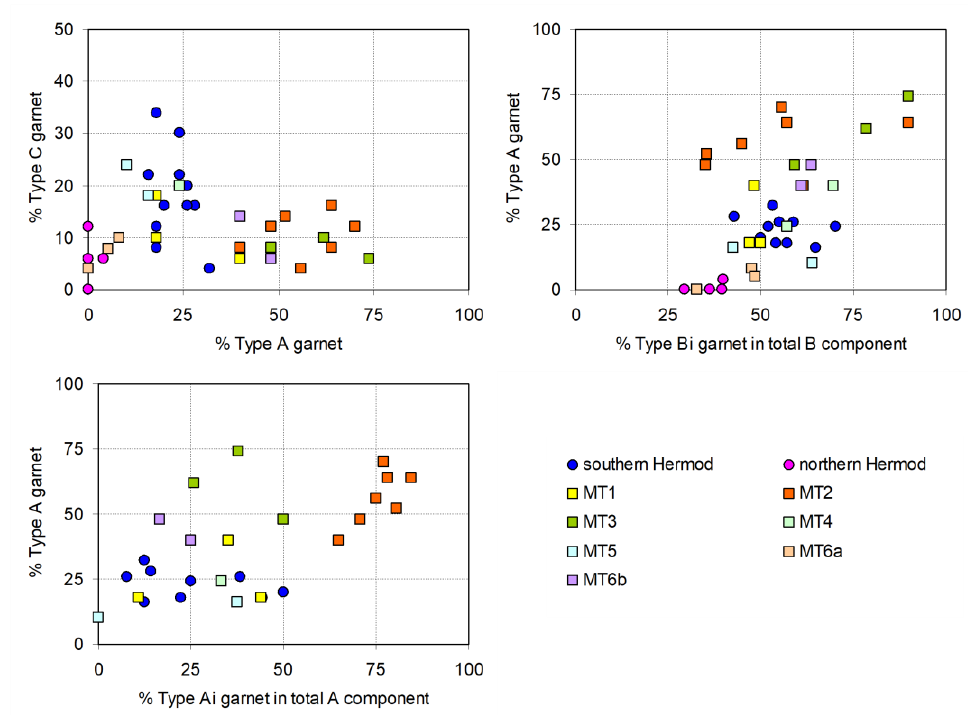
Figure 11. Comparison of garnet assemblage compositions in Hermod S2 sandstones with those found in Units MT1–MT6 (Morton et al., 1993). MT1 data from Norwegian wells 25/2-1 and 26/4-1; MT2 from UK wells 9/12-2 and 9/13-1; MT3 and MT4 from UK Well 9/13-1: MT5 from UK wells 9/13-1 and 9/23-1; MT6a from Norwegian wells 25/2-1 and 25/10-1; MT6b from Norwegian Well 16/1-1. Note the similarity between MT6a and the northern Hermod S2 group (Volund and Kobra) and between MT4/MT5 and the southern Hermod S2 group (Bøyla and Caterpillar).